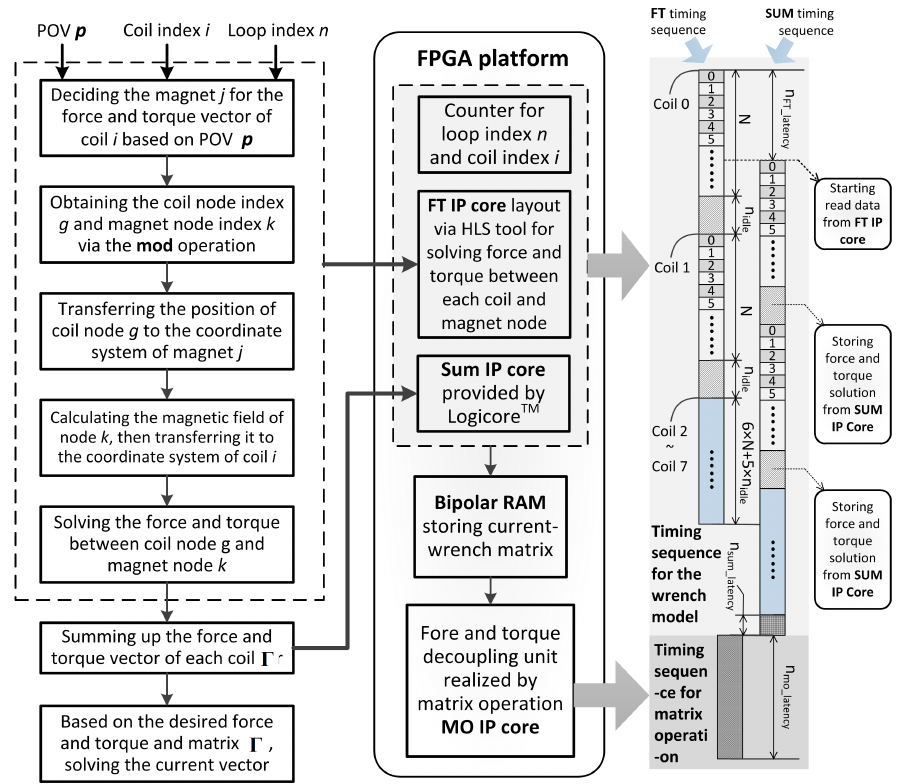
Figure 4. Flowchart, design structure, and timing sequence diagram of the current decoupling unit on the field programmable gate array (FPGA) platform. POV—position and orientation